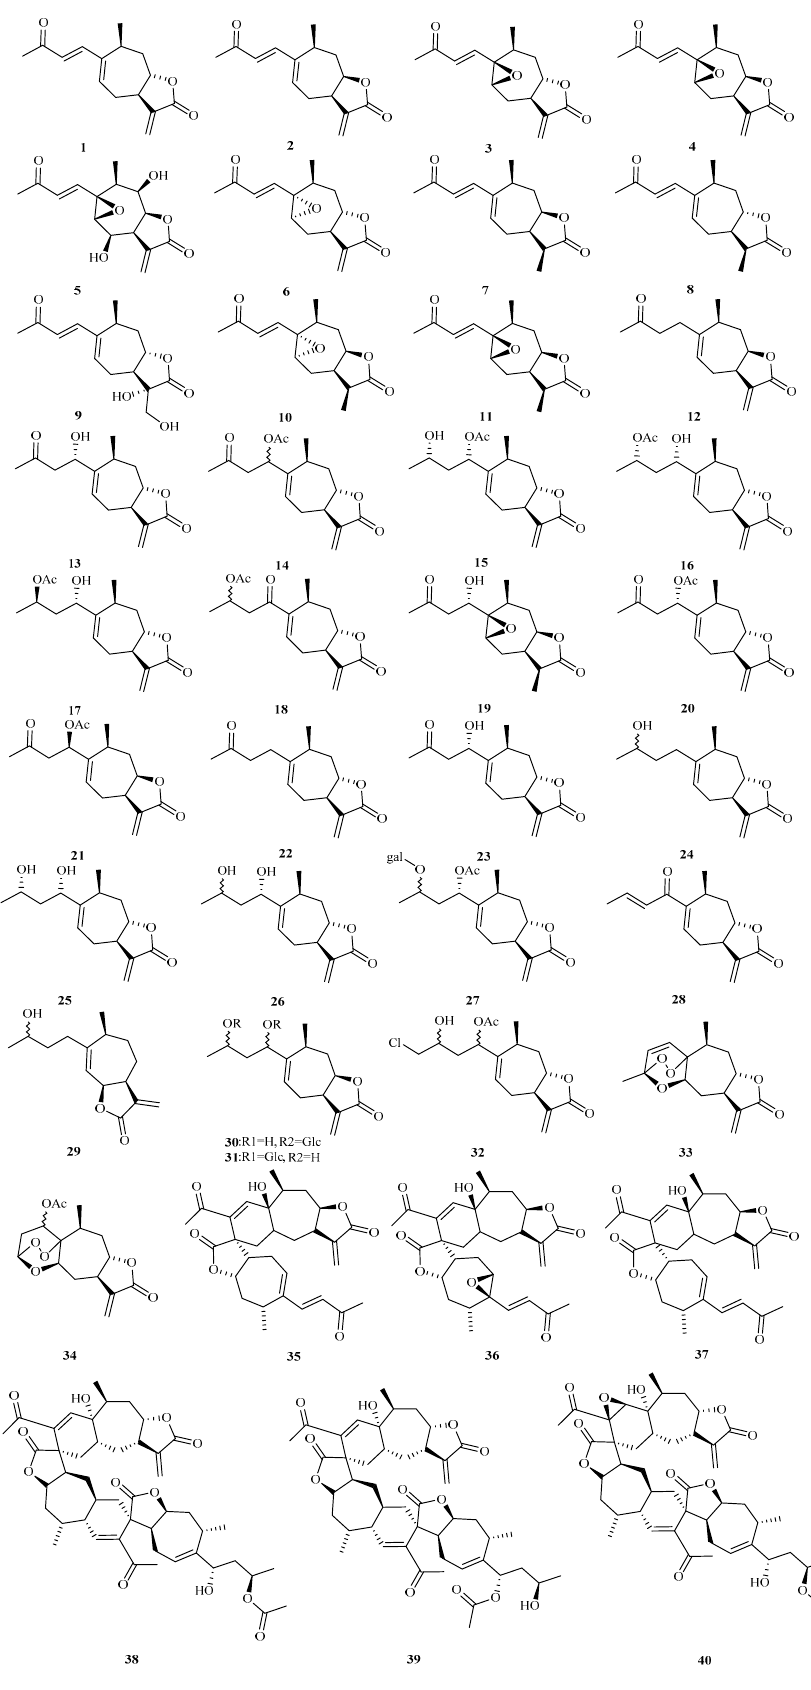
Figure 1. Chemical structures of the Xanthanolide isolated from X. strumarium.